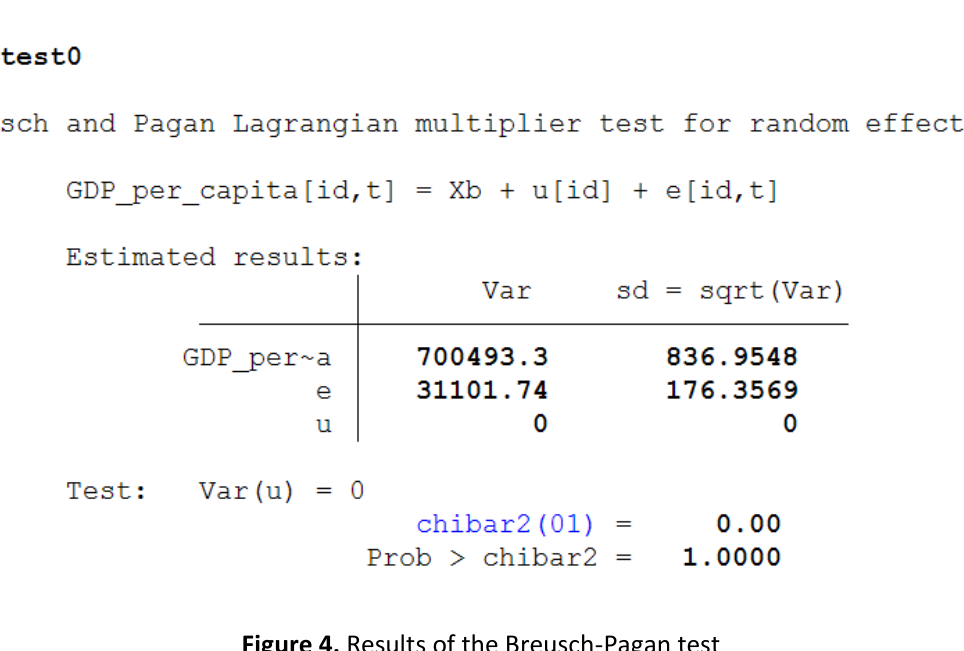
Figure 4. Results of the Breusch-Pagan